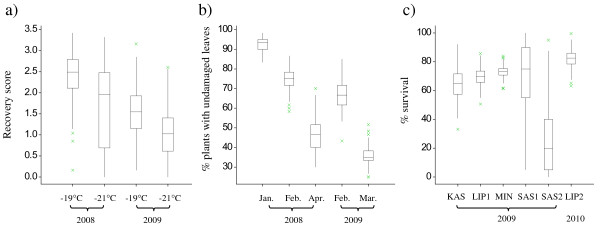
Phenotypic variation in three phenotyping platforms: a) controlled platform, b) semi-controlled platform, and c) field platform. The values are the average phenotypic raw value of replicates for each genotype. Boxes indicate the range of the middle 50% of the data with a horizontal line representing the median and vertical lines beyond the boxes indicate the upper and lower 25% of the data. Outliers are represented by crosses.